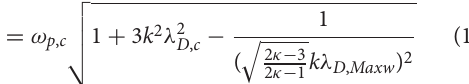
FIGURE 1 | (Left panel) Dispersion relation found by simulation for different κ approximation (black line). (Right panel) Im (1 /ε l ( K , (cid:127) )) for the same evdf.